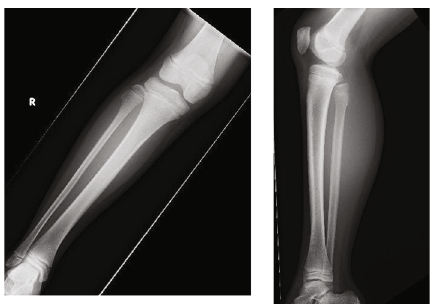
Figure 1: Radiograph of the right knee showing osteochondroma of the fi bular head.